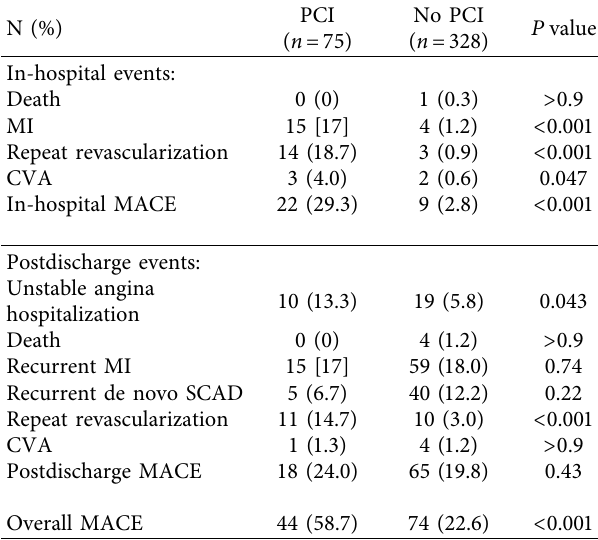
Table 5: In-hospital and postdischarge clinical adverse